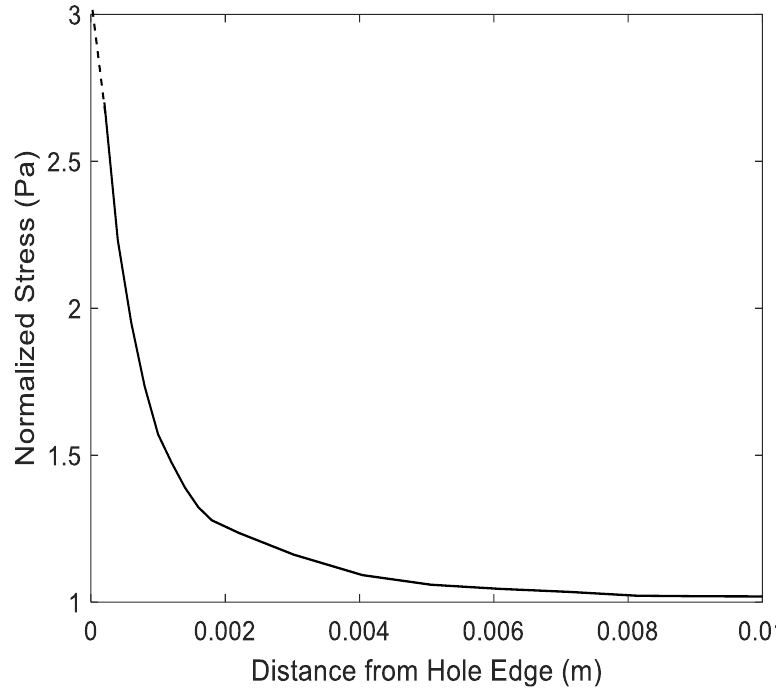
Figure 4. Finite element solution of y-normal stress along x -axis of a quarter of a plate with a center hole.